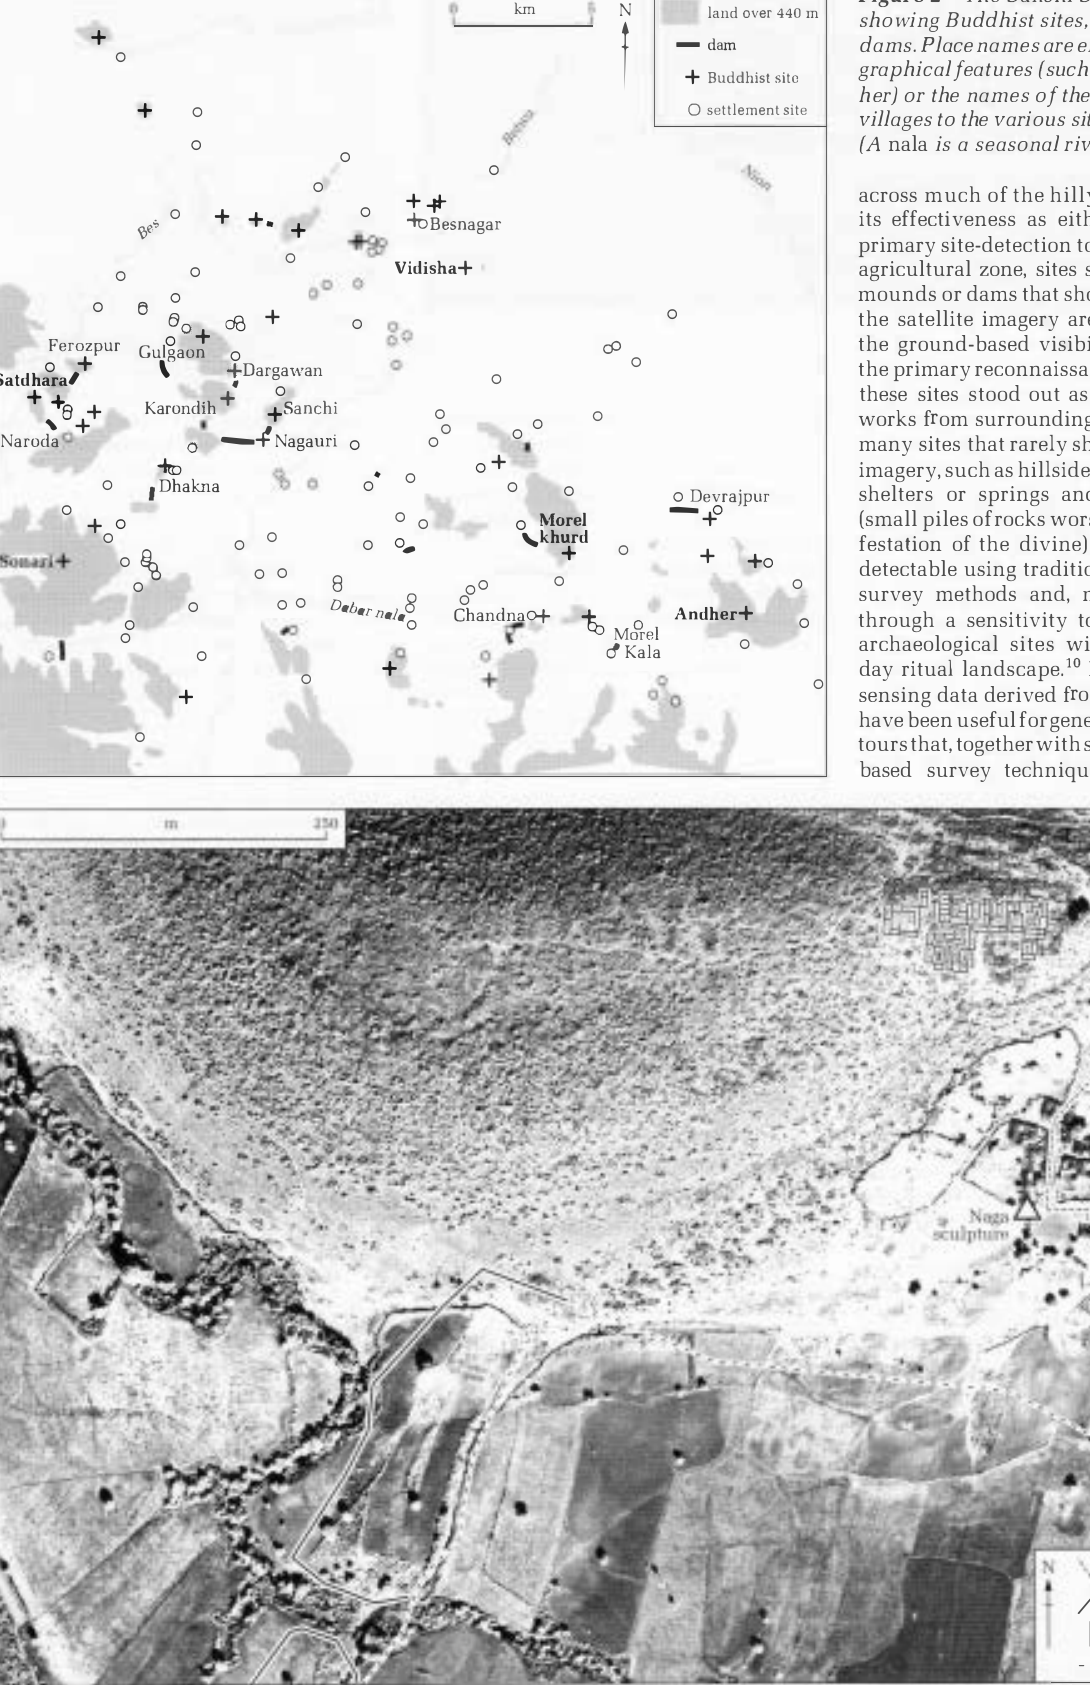
Figure 3 Mon astery remains on Ferozpur hill: high-resolution Quickbird satellite imagery with superimposed GPS-derived mapping